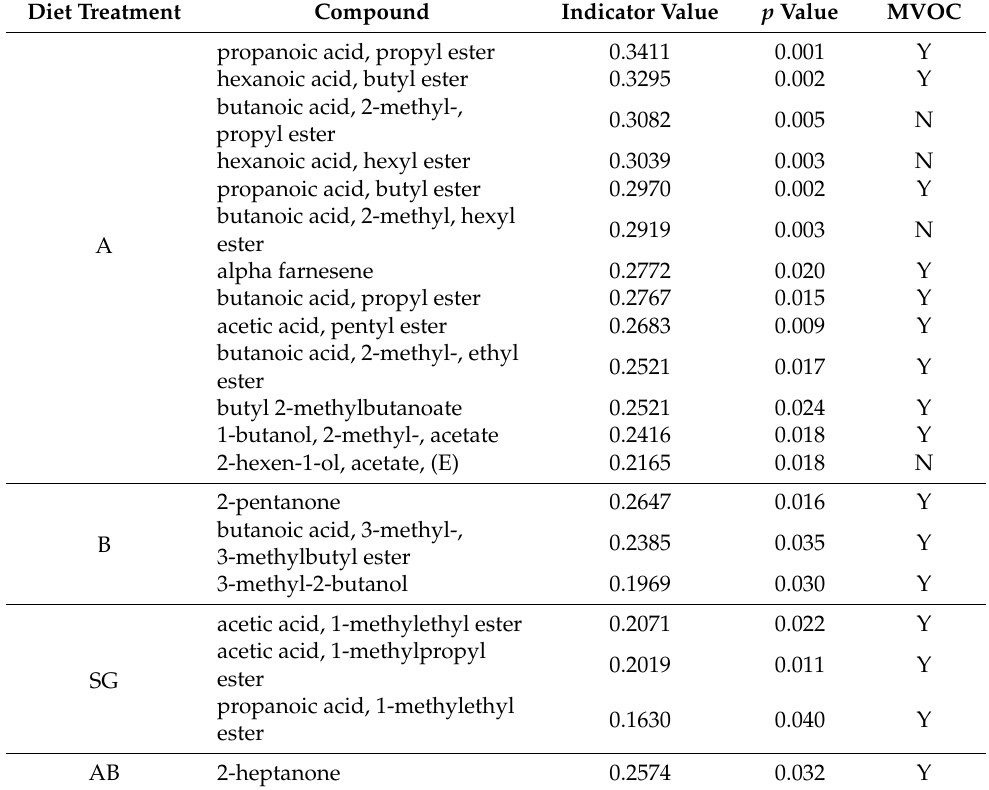
Table 3. Indicator VOCs for each diet treatment. A, apple; B, banana; SG, spent grain; AB, apple and banana; ASG, apple and spent grain; BSG, banana and spent grain. MVOC, microbial volatile organic compounds; Y, yes; N, no.